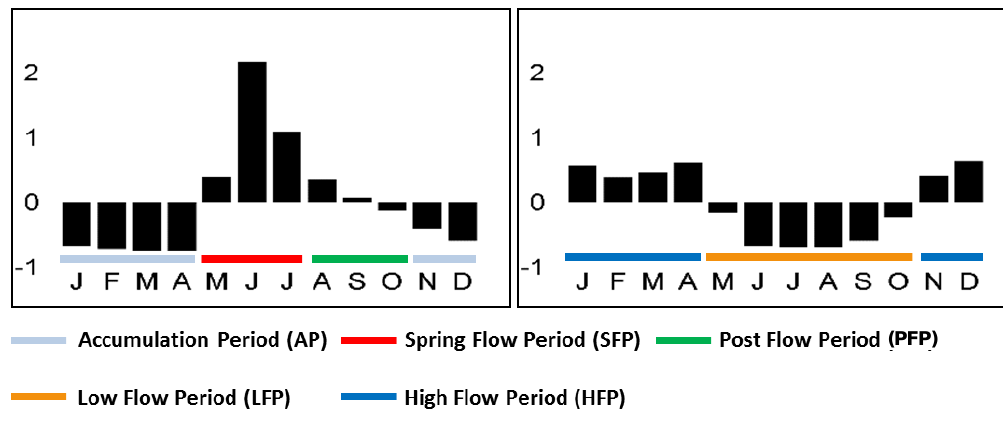
Figure 3. The standardized climatological hydrographs for Regions S3 ( left ) and R2 ( right ), showing the hydrological period divisions in each group